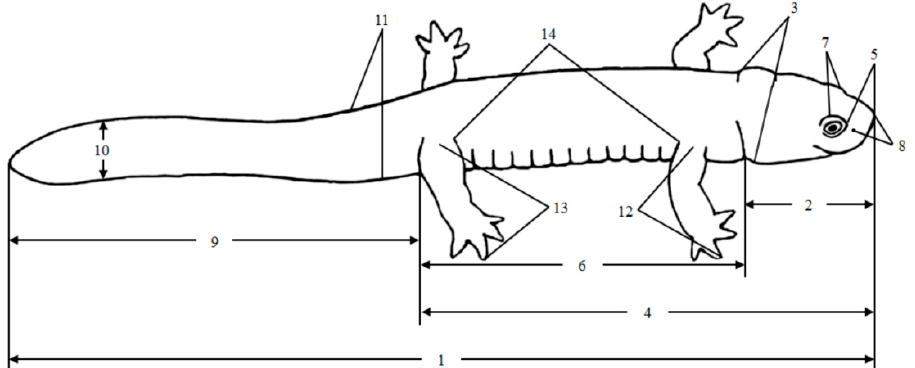
Figure 1. Urodela adult. The morphological variables used in the study (adapted from [39]). Note: